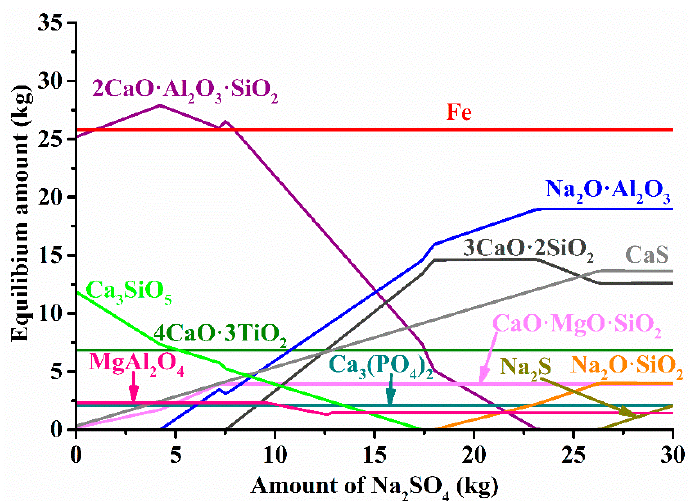
Figure 5. Effect of the Na 2 SO 4 addition on the equilibrium amounts of different phases at 1100 °C in the system that comprises 100% of the red mud sample U and 40% C.